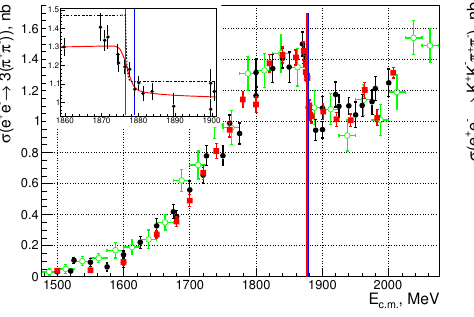
Figure 3. The e + e − → K + K − π + π − Born cross section measured with the CMD-3 detector in the 2017 run (squares). The results of the BaBar [27] measurements are shown by open circles. The inset shows the visible cross section with the fit described in the text. The vertical lines show the N ¯ N